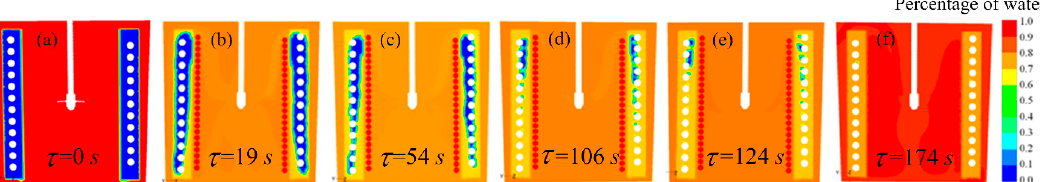
Figure 5. Ice melting variation with time (the height of the agitator was 80 mm). ( a ) τ = 0 s; ( b ) τ = 19 s;